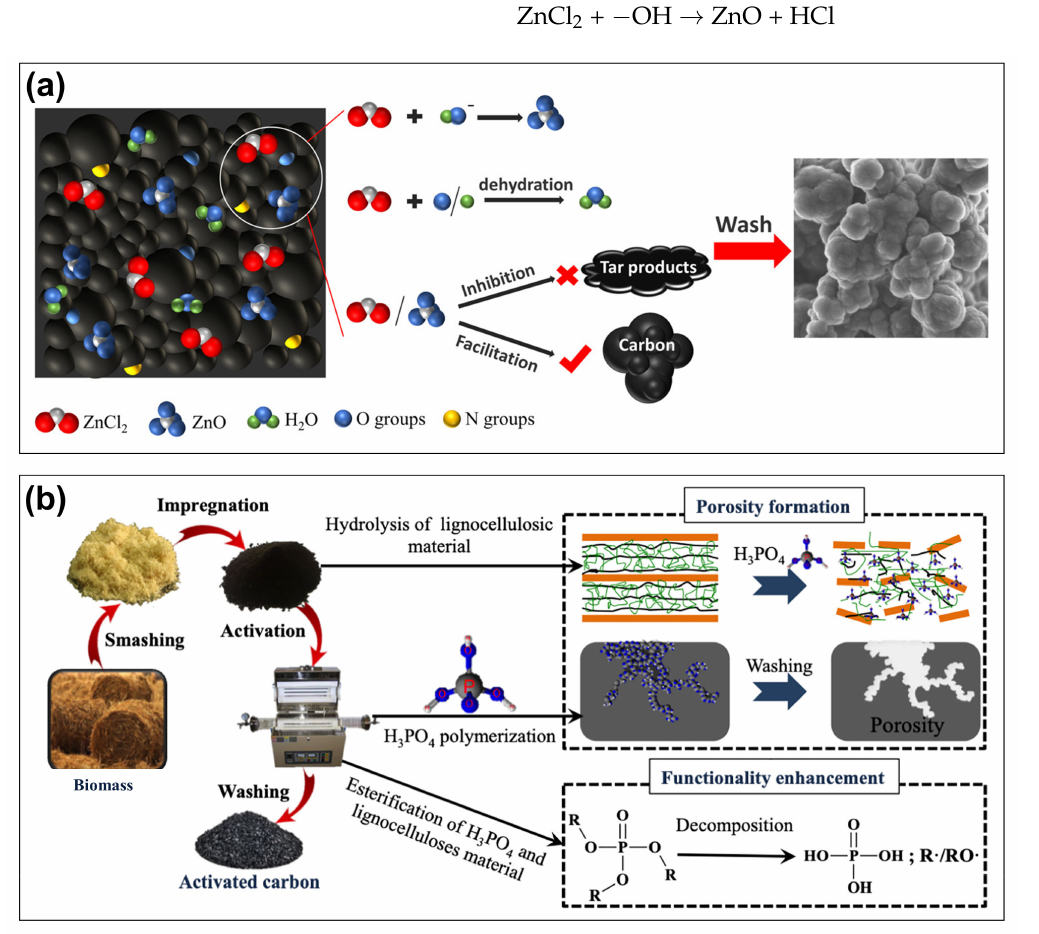
Figure 2. Diagram of activation mechanism of ( a ) ZnCl 2 [59] and ( b ) H 3 PO 4 for AC preparation